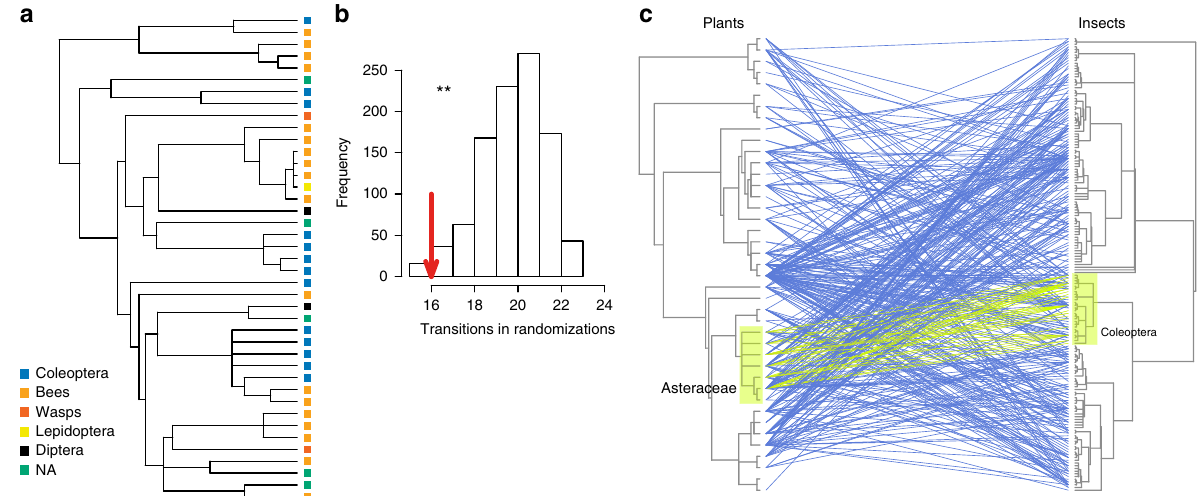
Fig. 1 The phylogenetic structure of plant – pollinator interactions. a The prevailing pollinator group mapped, as a categorical variable, within the phylogeny of the plants. NA: ≥ 2 groups with the highest visitation rate. b The histogram of the null model of evolutionary transitions according to the algorithm ‘ phylo. signal.disc ’ for discrete traits. The arrow shows the number of observed transitions of the trait, which is signi fi cantly lower than the randomized median (** P = 0.008). c The two clades showing the lowest residuals (highest phylogenetic congruence) in the Procrustean cophylogenetic analysis. For